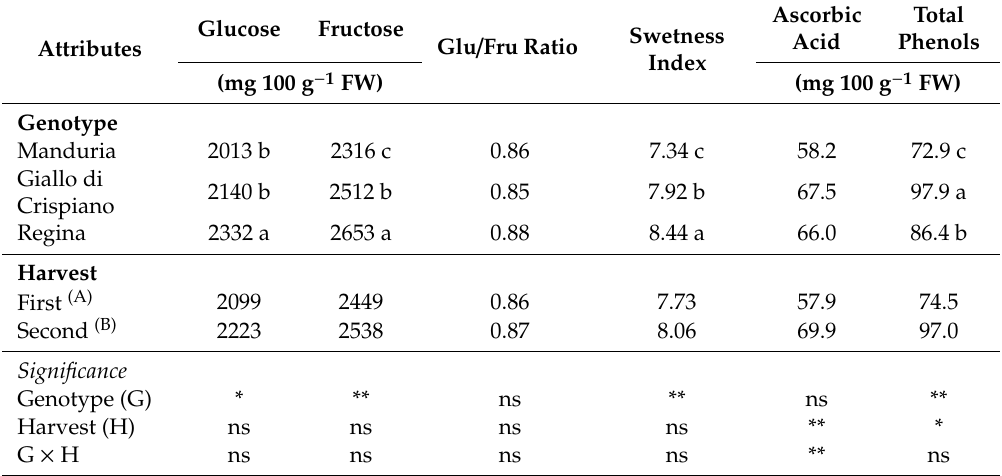
Table 4. Main e ff ects of genotype and harvest time on glucose and fructose content, glucose /